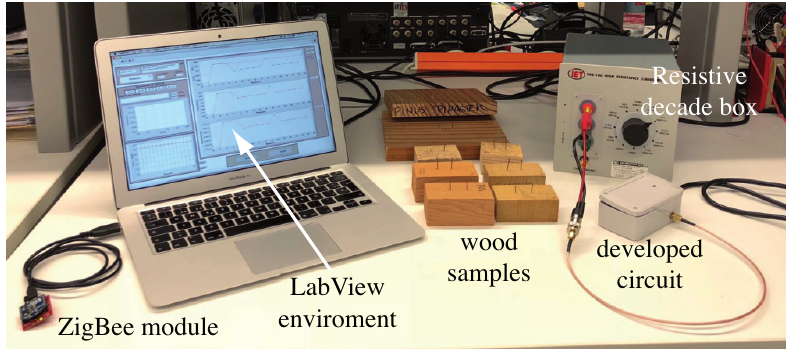
Figure 4. Testbench for wood resistance measurement using the proposed AC